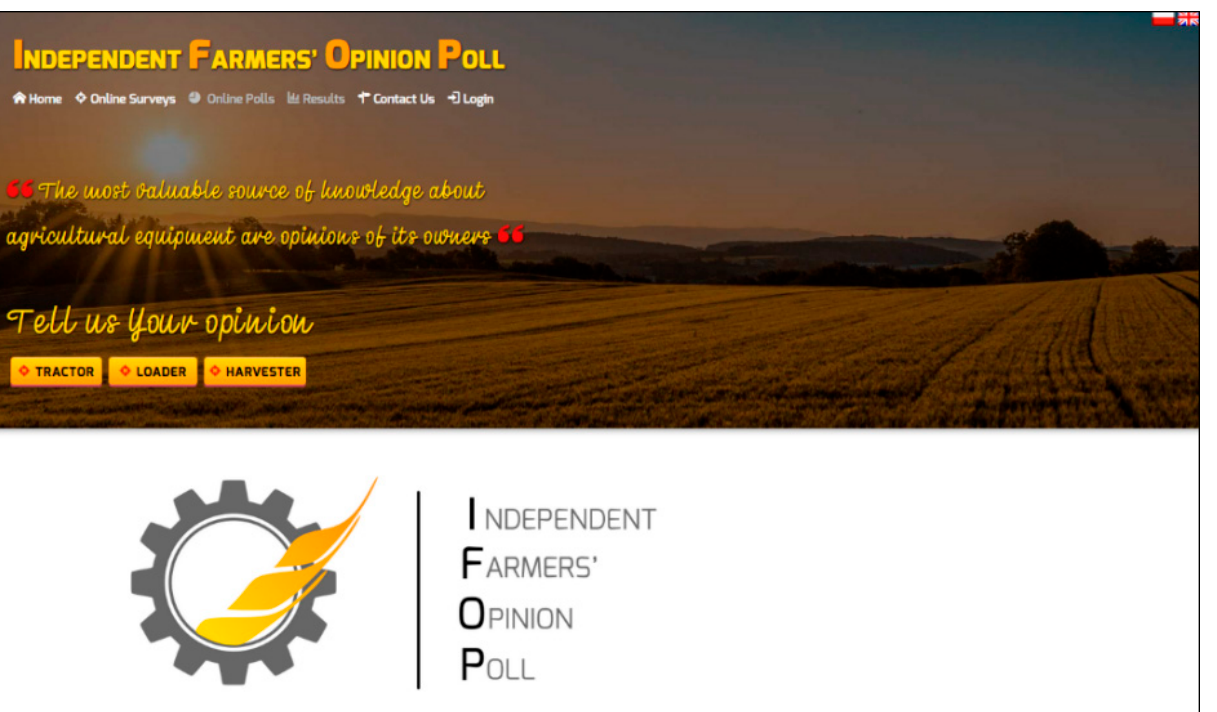
Figure 1. The start-up screen of the IFOP platform, at http://www.nbor.pl/index.php?lang=en (accessed on 1 September